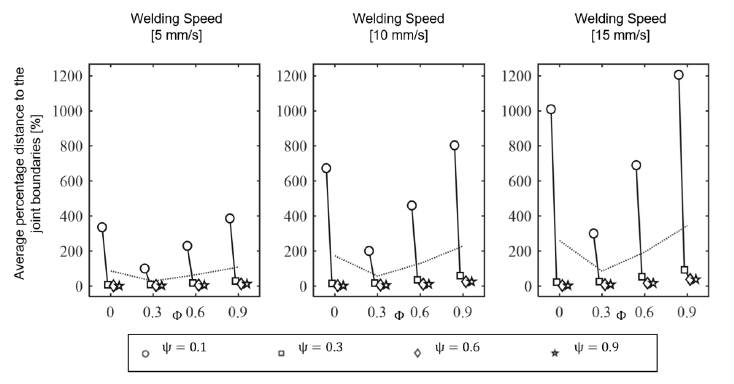
Figure 4. Design of Experiment results of different smoothing